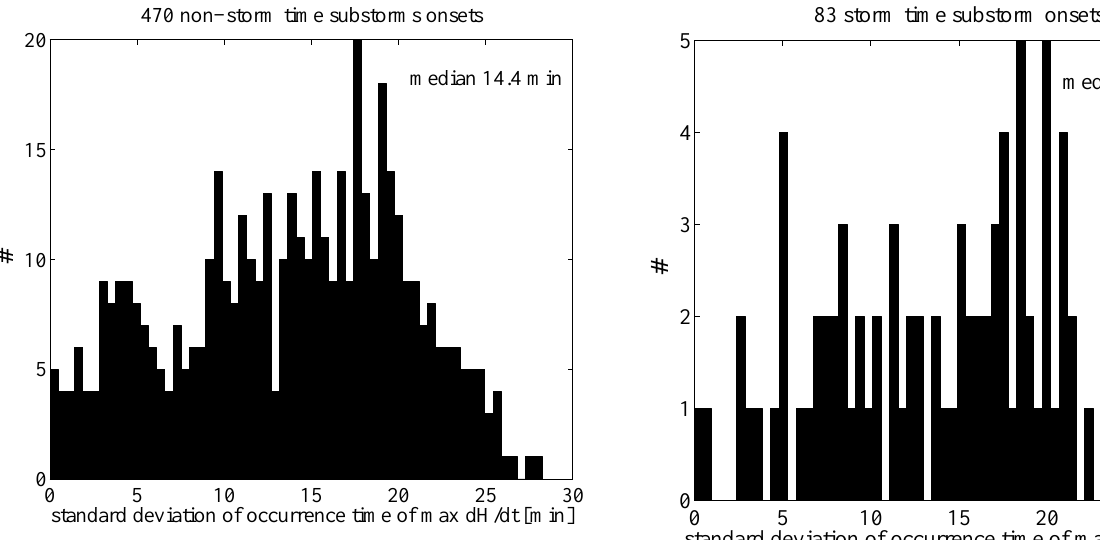
Fig. 6. Histogram showing the standard deviation of times of occur- rence of max | d H /dt | for each non-storm time event, 470 onsets. Fig. 7. Standard deviation of time of occurrence of max | d H /dt | for each storm time event, 83